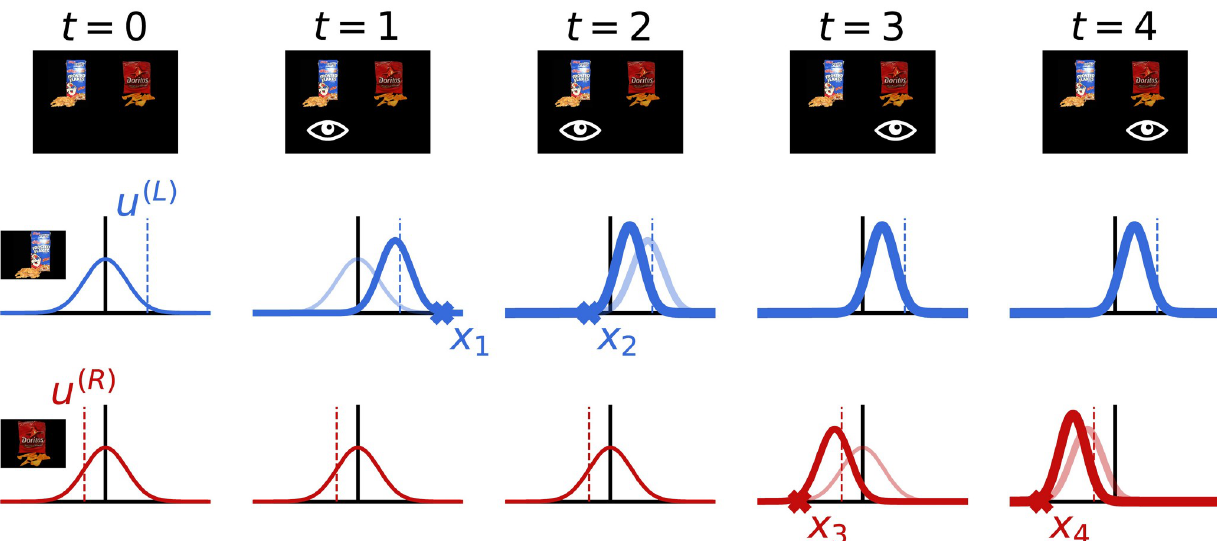
Fig 1. Sampling and belief updating in the binary choice task. The top row shows the experimental display, with the fixated item denoted by the eye symbol. The bottom two rows depict the first few steps of the sampling and belief updating process. The decision maker’s beliefs about the value of each item are denoted by the Gaussian probability density curves. The true values of each item (dashed lines) are sampled from standard normal distributions; this is captured in the decision maker’s initial belief state (first column). Every time step, t , the decision maker fixates one of the items and receives a noisy sample about the true value of that item ( x marks). She then updates her belief about the value of the fixated item using Bayesian updating (shift from light t to dark curve). The beliefs for the unfixated item are not updated. The process repeats each time step until the decision maker terminates sampling, at which point she chooses the item with maximal posterior